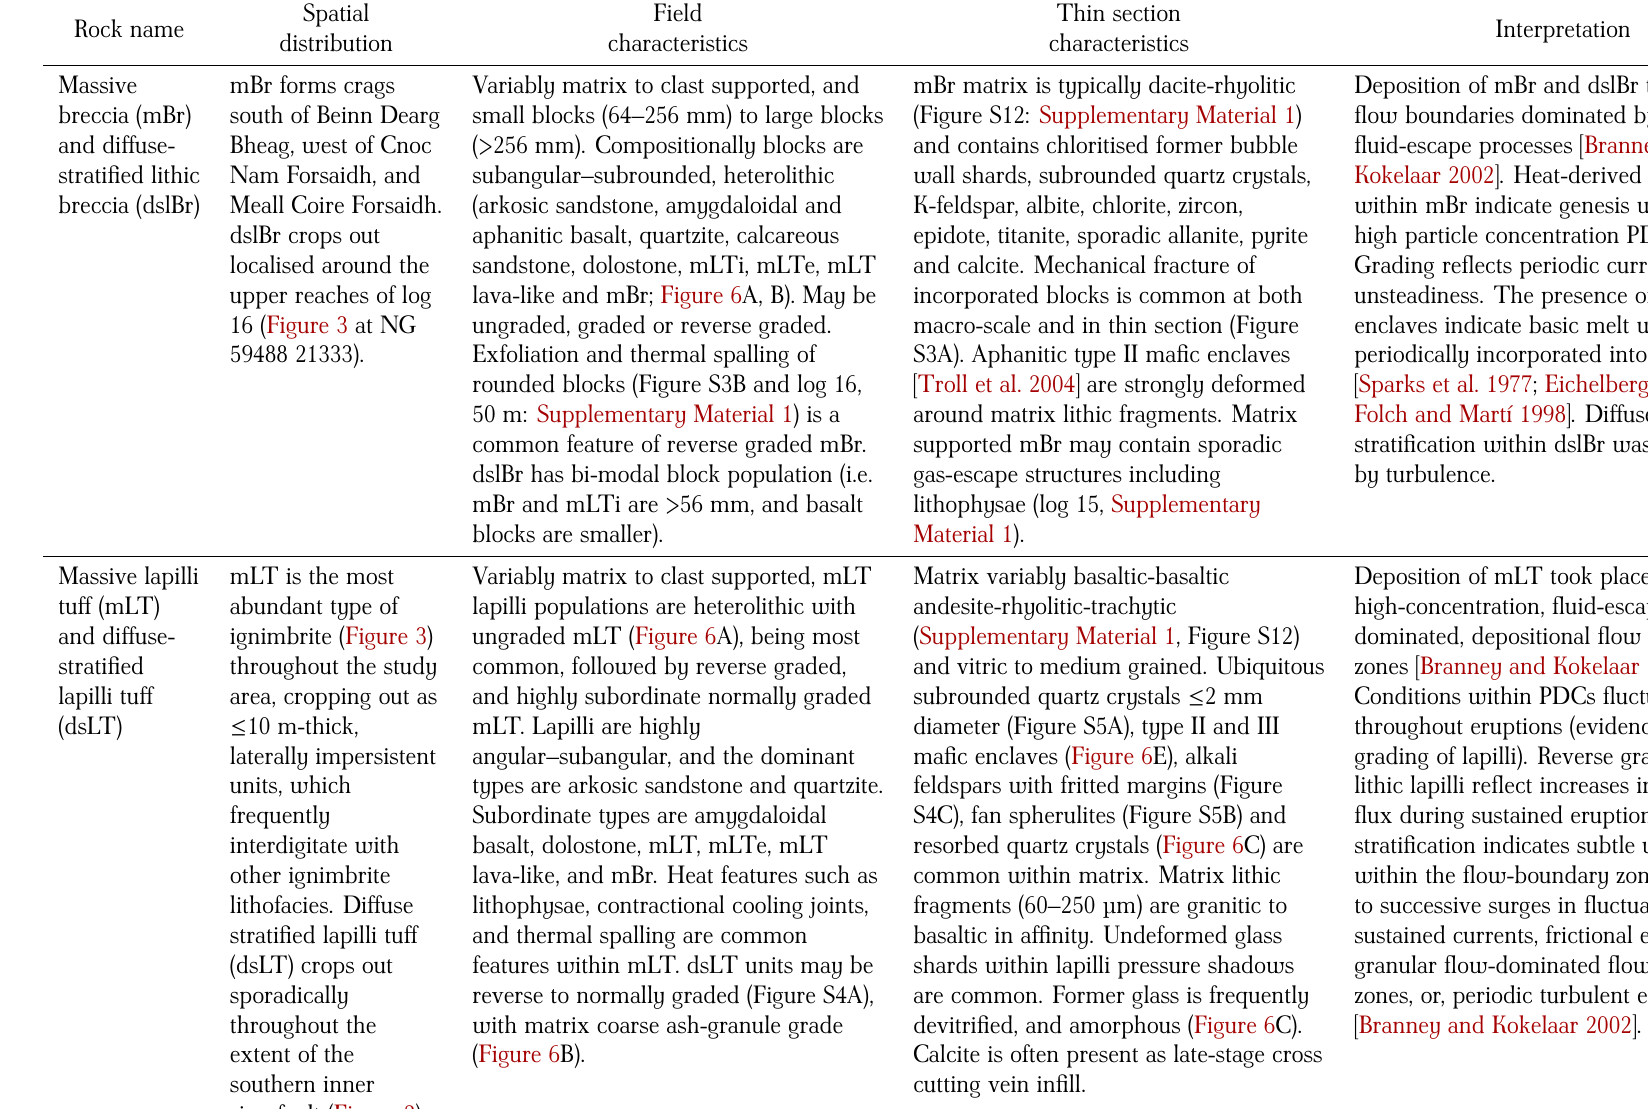
Table 3: Massive breccia (mBr), diffuse stratified lithic breccia (dslBr), massive lapilli tuff (mLT), and diffuse stratified lapilli tuff (dsLT) of the